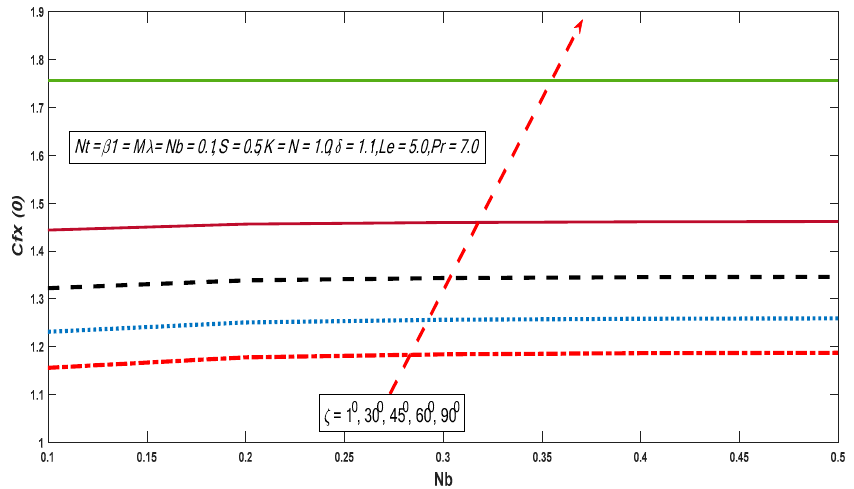
Figure 22. Variations skin friction with 𝑁𝑏 for different values of 𝜁 .